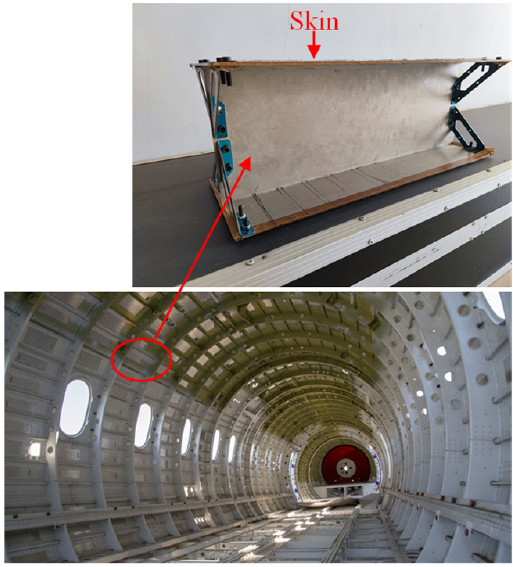
Figure 1. The physical figure of the aircraft long truss